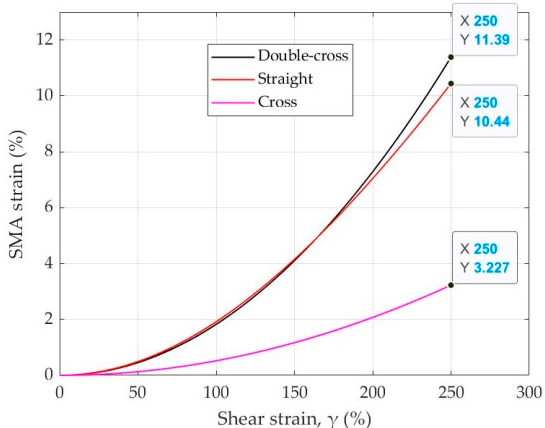
Figure 8. Strain in SMA wires due to shear strain of SMA-LRB for the three different wires arrangement.